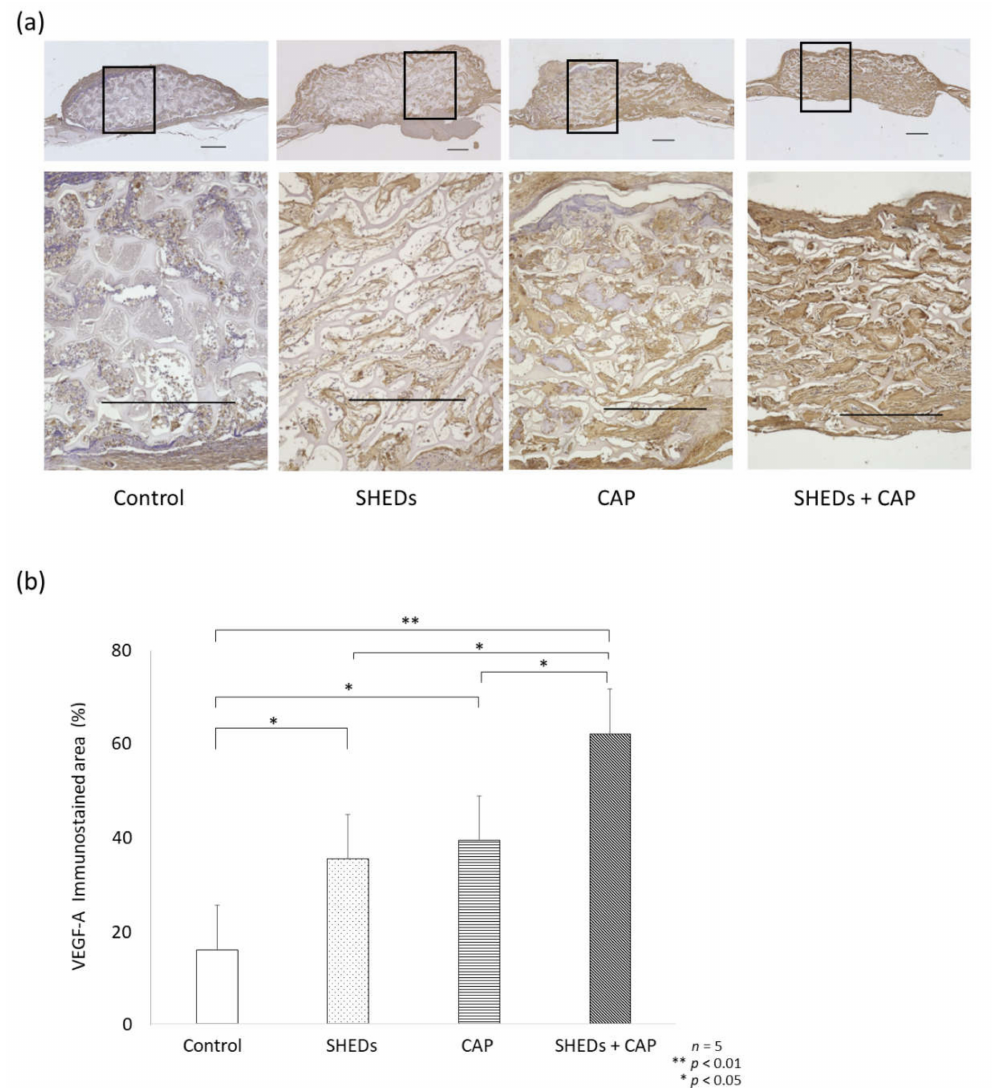
Figure 4. IHC analysis of VEGF. ( a ) IHC analysis of VEGF expression showed clearer and more vividly stained areas in the SHEDs, CAP, and SHEDs + CAP groups than in the control group. ( b ) The proportion of the VEGF-stained area was significantly higher in the SHEDs, CAP, and SHEDs + CAP groups than in the control group. n = 5 for each group, ** p < 0.01, * p < 0.05. VEGF scale bar = 500 µ